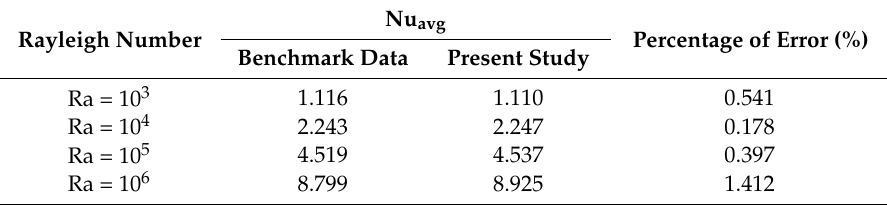
Table 2. Comparison of results obtained in this study with benchmark data of Davis [55].